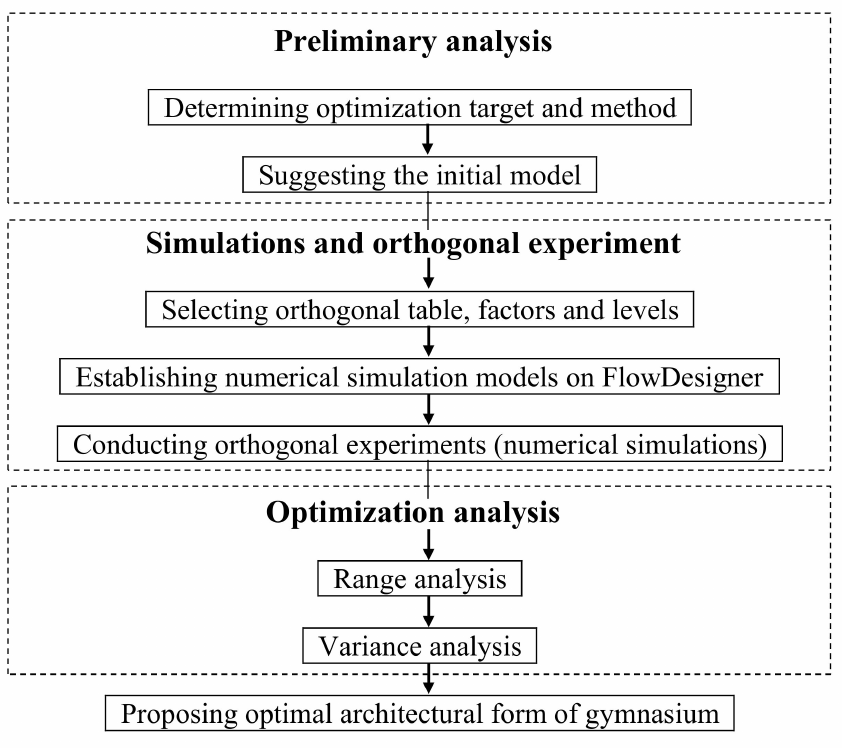
Figure 1. Flow chart of the hybrid method for simulation and